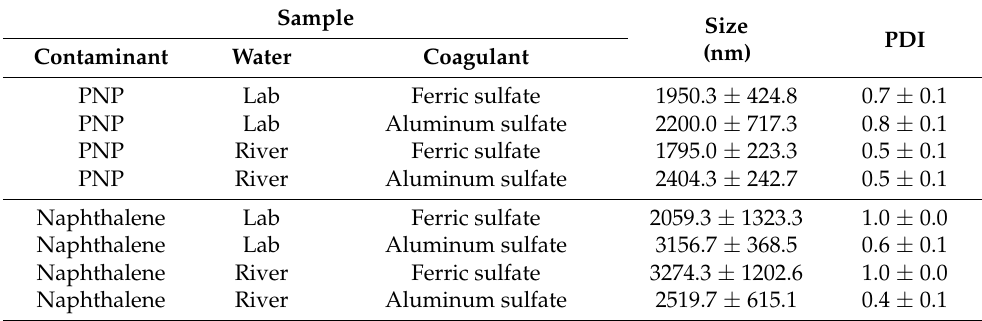
Table 5. Particle size distribution of floc samples that contain PNP and naphthalene model